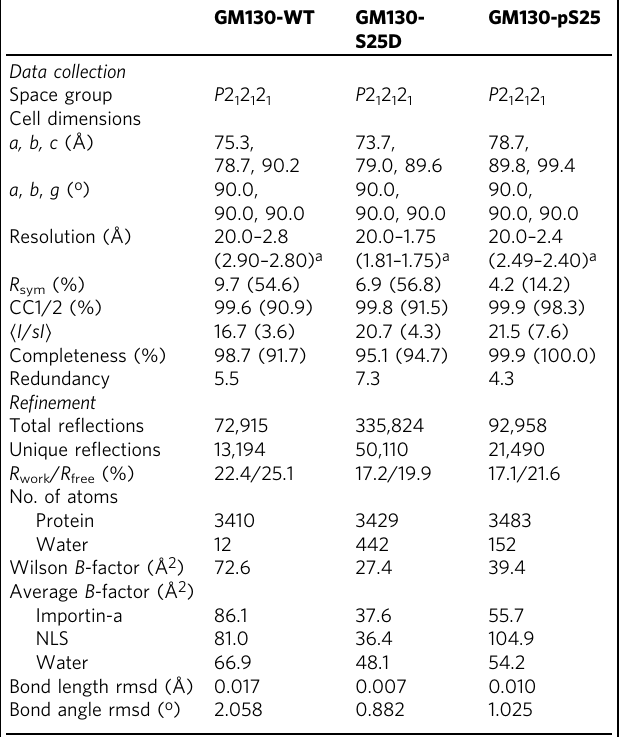
Table 1 Data collection and re fi nement